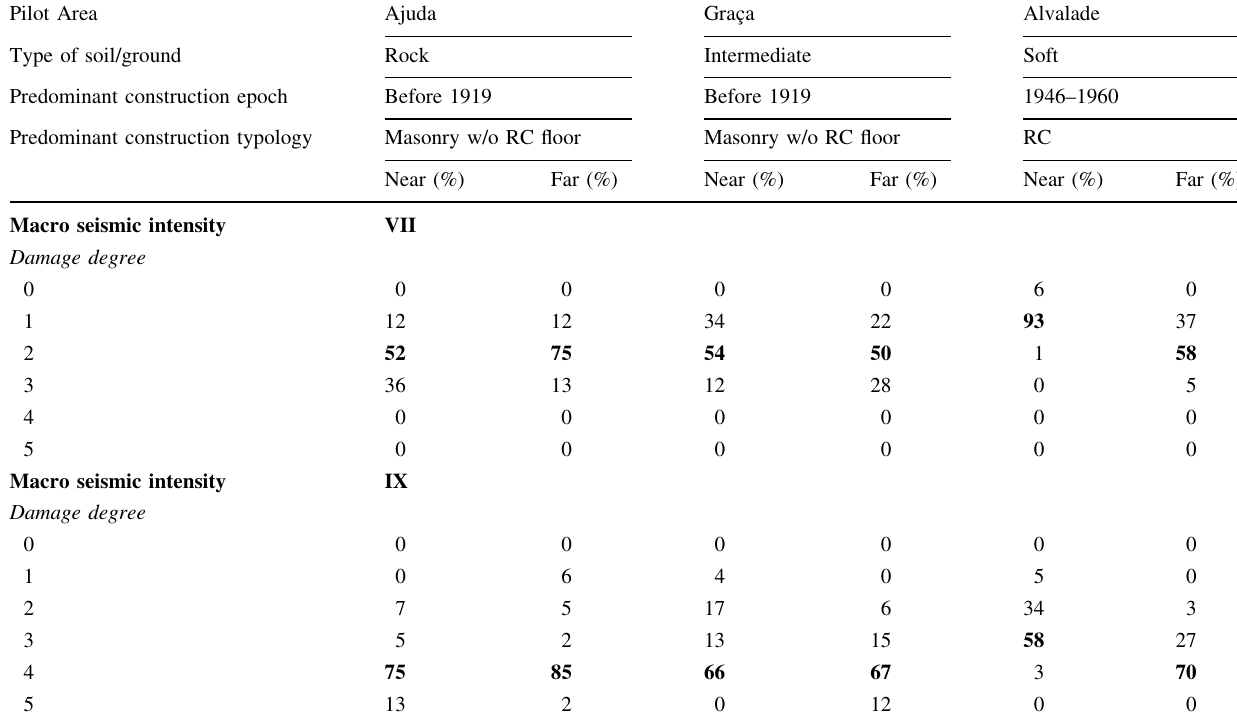
Table 10 Percentage of buildings per damage degree for all seismic scenarios in all pilot areas Pilot Area Ajuda Grac¸a Alvalade Type of soil/ground Rock Intermediate Soft Predominant construction